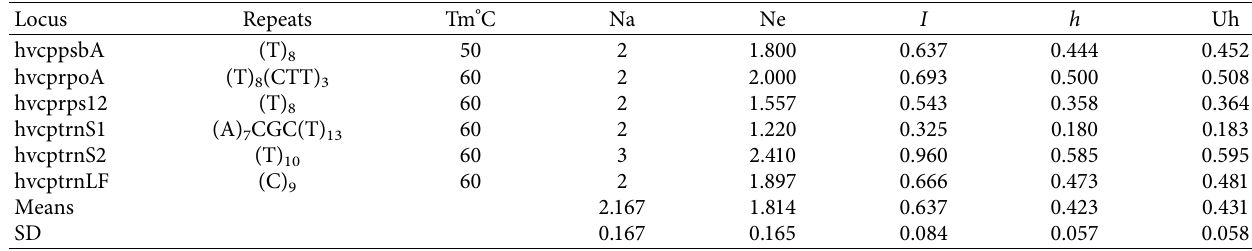
Table 2: Characteristics of the six cpSSR (chloroplast microsatellites) molecular markers and genetic diversity parameters across the 60 studied barley landraces. Tm: primer melting temperature, Na: number of alleles per locus, Ne: number of effective alleles per locus, I: Shannon’s information index, h: genetic diversity, uh: unbiased genetic diversity.